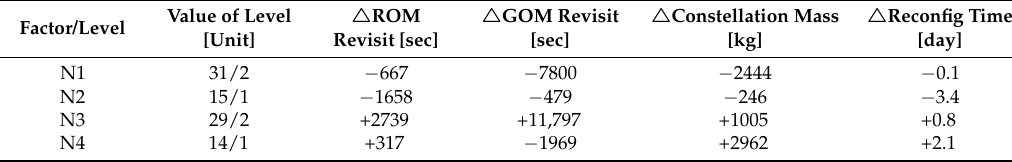
Table 9. Main effects from Latin Hypercube Sampling with 100 design